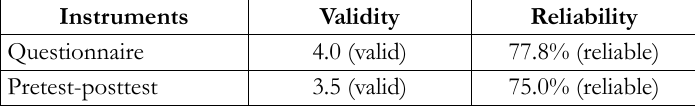
Table 5. The Validity of Questionnaire and